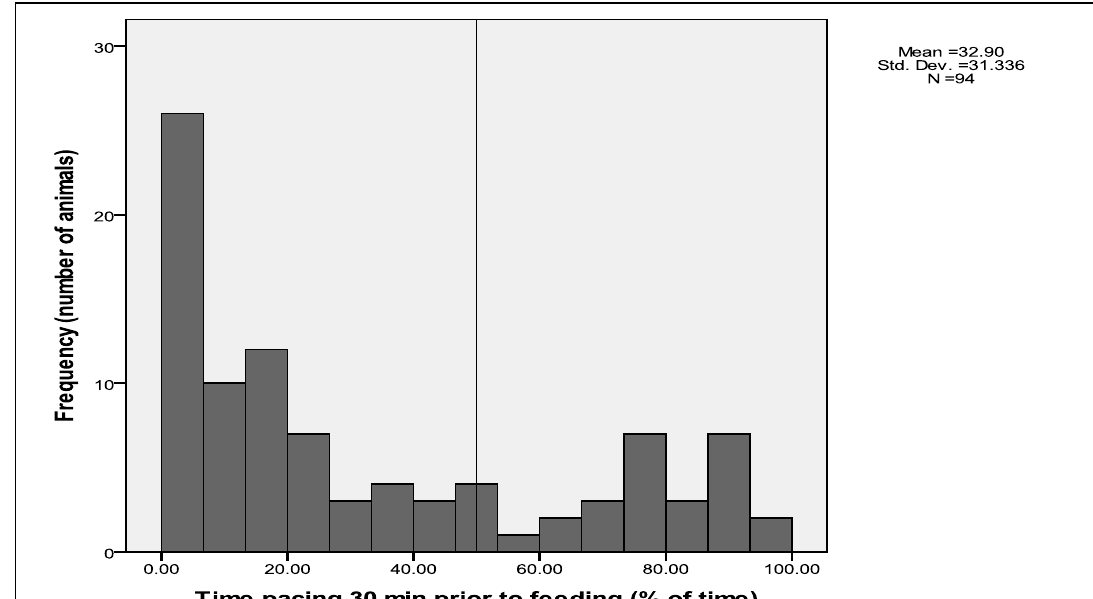
Figure 3. Histogram showing the distribution of time that sheep spent pacing in the 30 min prior to